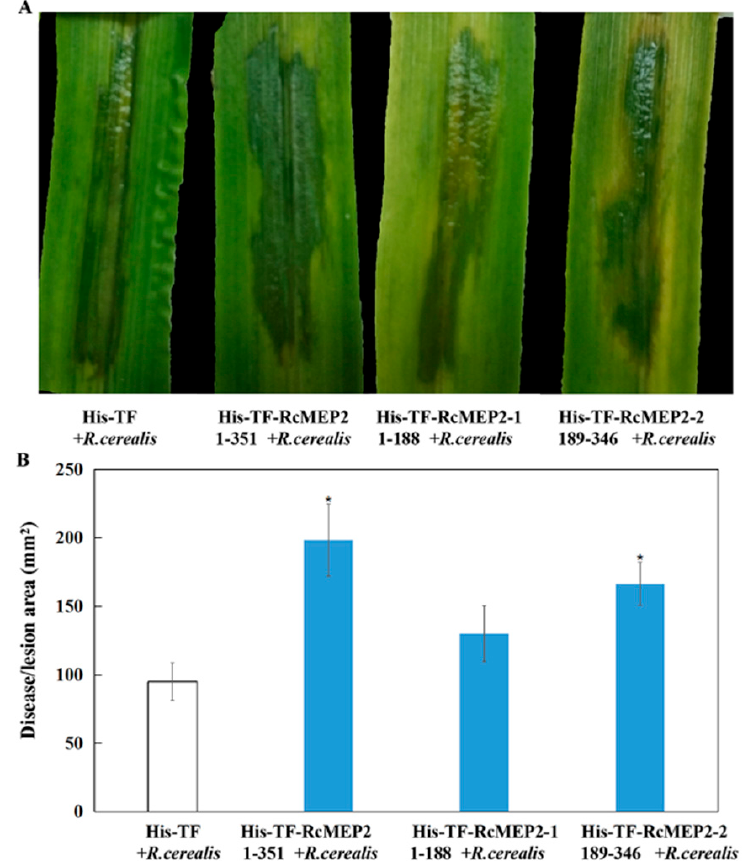
Figure 7. RcMEP2 protein and its M35 domain-containing peptide contribute to pathogenicity of Rhizoctonia cerealis to wheat. ( A ) His-TF-RcMEP2 and His-TF-RcMEP2-2 (M35 domain-containing peptide) enhanced pathogenicity symptoms of the invaded R. cerealis mycelia in leaves of a wheat cv. Wenmai 6. Photos of the treated leaves were taken at three days post-inoculation with the fungus and the lesion area was measured. ( B ) Disease severity measured as area of lesion induced by R. cerealis liquid mycelia on leaves shown in (A). Asterisk * indicates significant difference between His-TF- RcMEP2 or His-TF-RcMEP2-2 treatment and His-TF (CK) treatment ( p < 0.05, t -test).